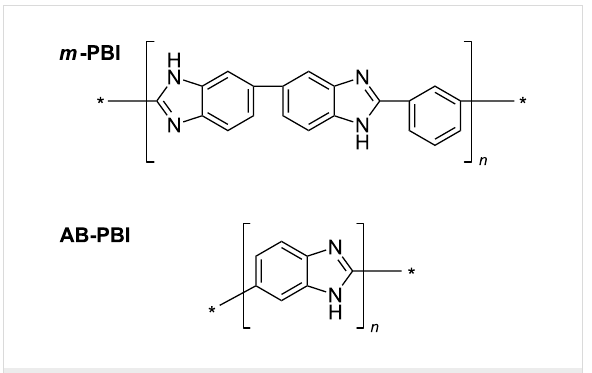
Figure 3: Chemical structures of m -PBI (poly[2,2-( m -phenylene)-5,5- bibenzimidazole]) and AB-PBI (poly(2,5-benzimidazole)). m -PBI and AB-PBI are the two most prominent members of the PBI family. These are aromatic heterocylic polymers containing benzimidazole